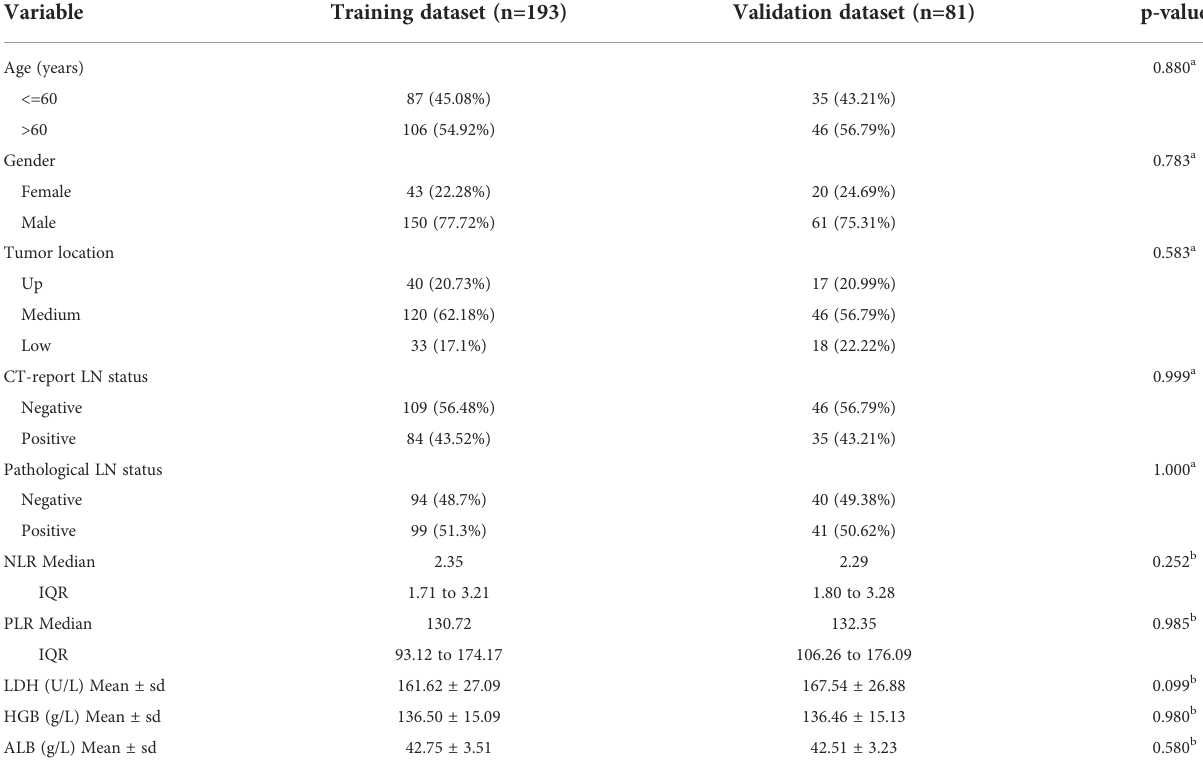
TABLE 1 Baseline characteristics of 274 ESCC patients in the training and validation